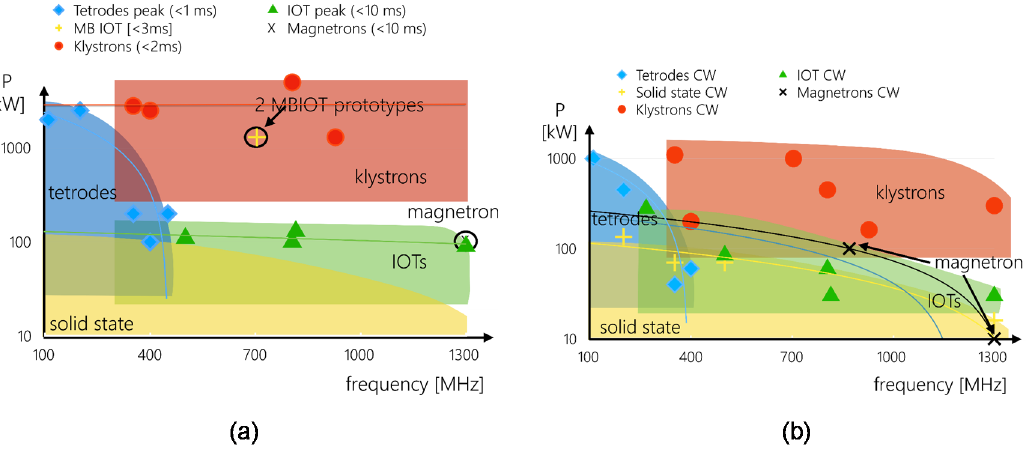
Figure 14. Power and frequency of various RF sources for pulsed ( a ) and CW ( b ) operations up to 1.3 GHz. 1.3